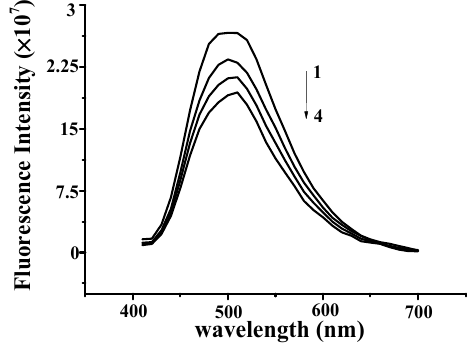
Figure 5. Cationic fluorescence quenching spectra of DNA–YP ( C DNA = 0.9 mg/mL, C YP = 1.5 mg/mL) upon the addition of different concentrations of NaCl: (1) 0 mg/mL, (2) 0.2 mg/mL, (3) 0.4 mg/mL, and (4) 0.6 mg/mL.